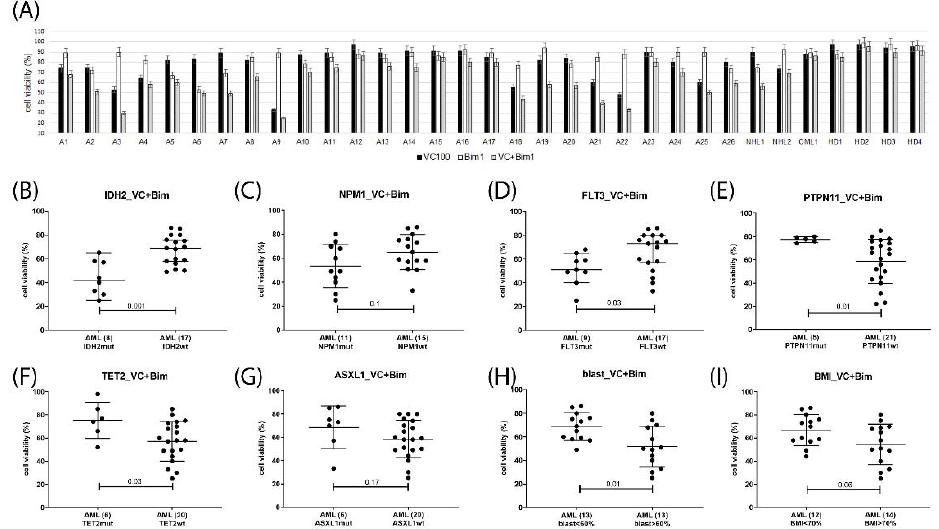
Figure 8. Response markers in venetoclax and bimiralisib (PQR309) combination treatment. Cell viability was determined in mononuclear cells isolated from AML patients peripheral blood or bone marrow after 20 h treatment with 100 nM venetoclax and 1 µ M bimiralisib ( A ). Hematological cells were grouped according to single gene mutation status of IDH2 ( B ), NPM1 ( C ), FLT3 ( D ), PTPN11 ( E ), TET2 ( F ), ASXL1 ( G ), peripheral blast cell percentage ( H ), and bone marrow blast cell percentage ( I ). Number of samples in each group are indicated in parentheses. Significance of differences in median values was calculated by Mann–Whitney